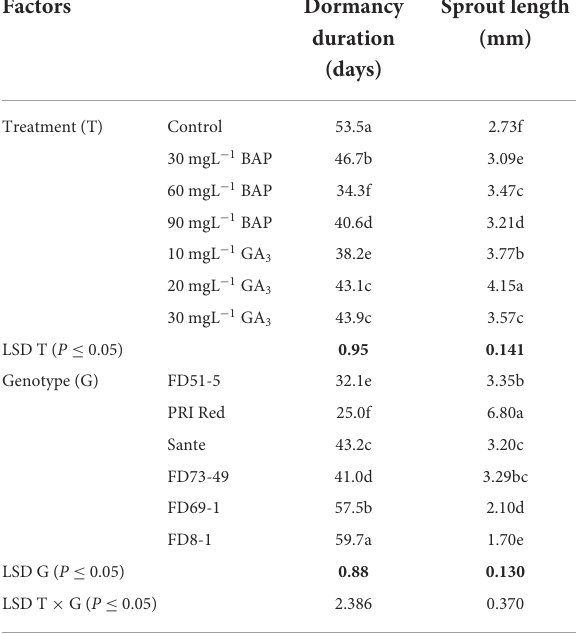
TABLE 1A Mean comparison of dormancy duration and sprout length of potato tubers influenced by PGRs and genotypes during the year